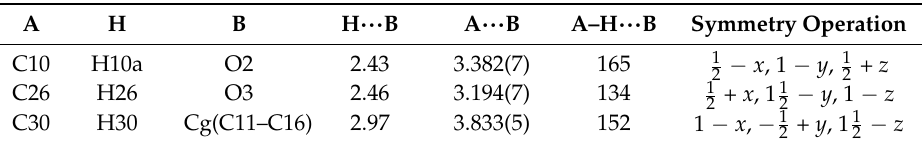
Table 1. Geometric parameters (Å, °) characterizing the non-covalent (A–H···B) interactions present in the crystal of 1 .